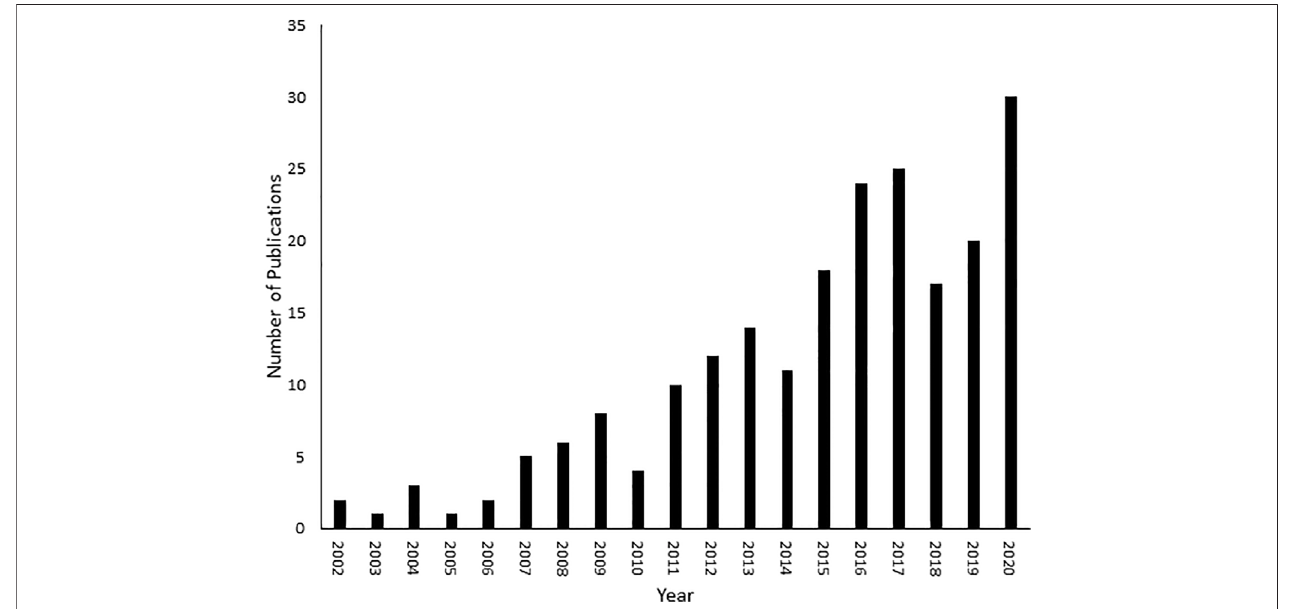
FIGURE1| Numberof fl uxomicpublications.AliteraturereviewwasconductedonSciFinder(https://sci fi nder.cas.org/sci fi nder/view/sci fi nder/sci fi nderExplore.jsf) using the keyword fl